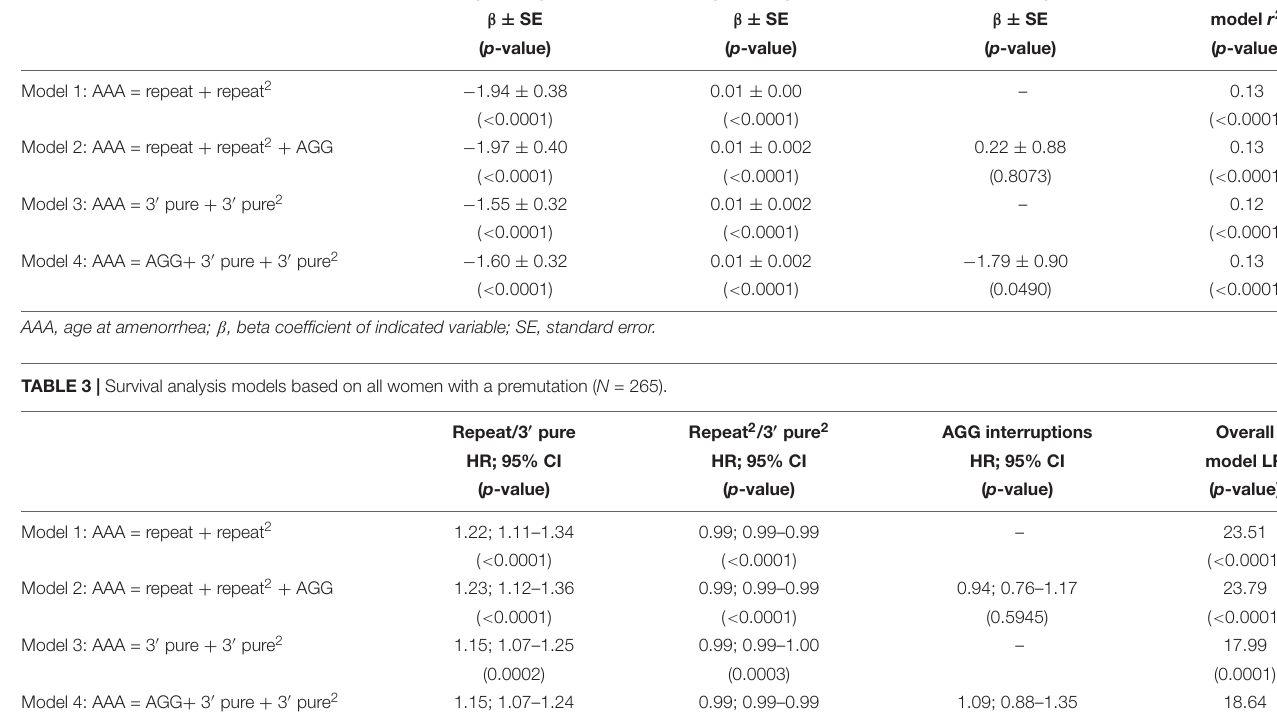
TABLE 2 | Linear regression models based on women with a premutation who had experienced amenorrhea ( N = 164). Repeat/3 (cid:48) pure Repeat 2 /3 (cid:48) pure 2